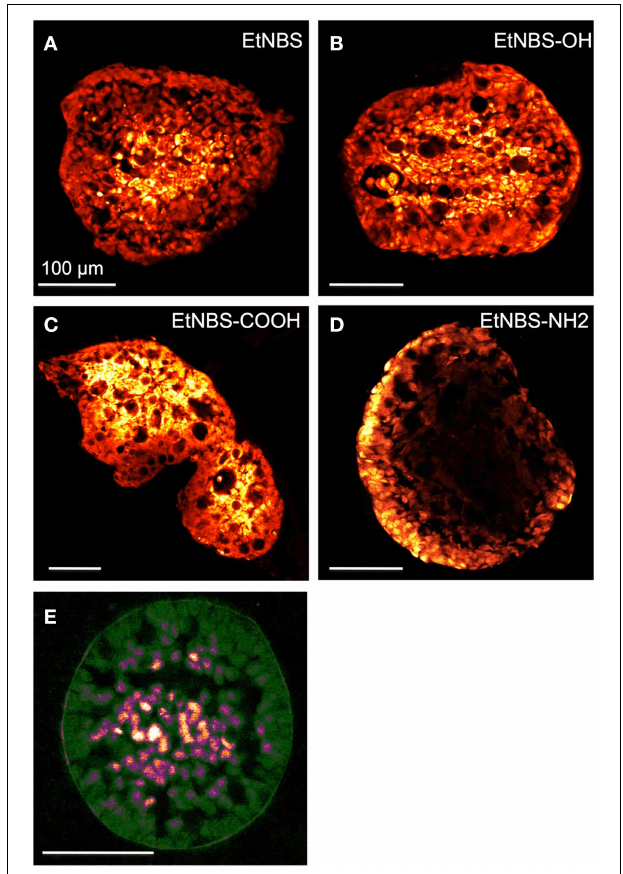
FIGURE 2 | Physical sectioning and fluorescence microscopy can show the uptake and localization patterns of photosensitizers with 3D spheroids. An advantage of spheroid cultures is the ease with which they can be manipulated so as to examine the microscale patterns of photosensitizer uptake. In this figure reproduced from Klein et al. [29], OVCAR5 spheroids were incubatedwithEtNBSandseveralofitsderivativesfor4.5hpriortobeingfrozen and sliced into thin sections. These sections can be readily imaged by confocal microscopytovisualizethedifferentialuptakeofthecompounds. (A) EtNBS, (B) EtNBS-OH, (C) EtNBS-COOH,and (D) EtNBS-NH2. (E) Two-photonimageofa pimodinazole-stained 3D tumor nodule shown here in false color to